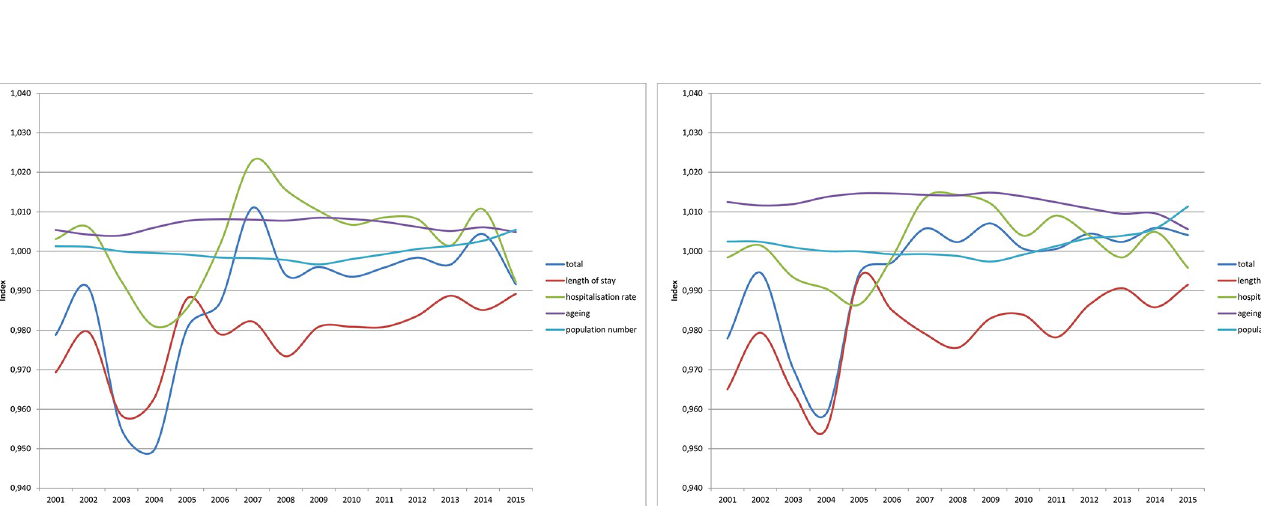
PLOS ONE | https://doi.org/10.1371/journal.pone.0243322 December11, 2020 10 /